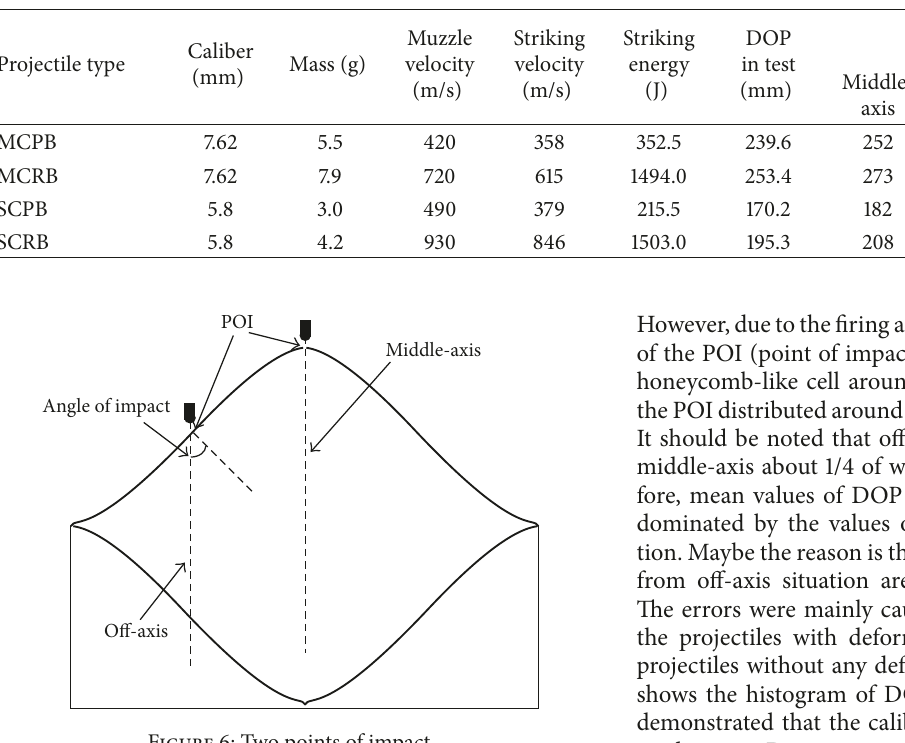
Figure 6: Two points of